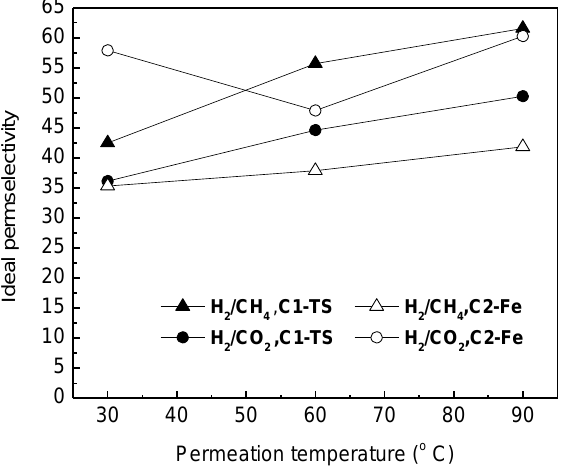
/ CH / CO 4 and H 2 2 selectivities for the results of Figure